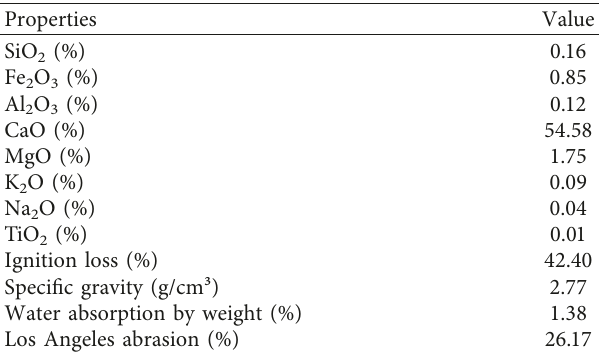
Table 4: Chemical, physical, and mechanical properties of the limestone aggregates.